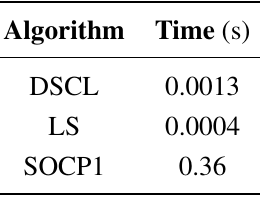
Table 2. The average running time per node per M for known P , when N = 25 , M = 50 , σ = 0 dB, R = 6 m, M T